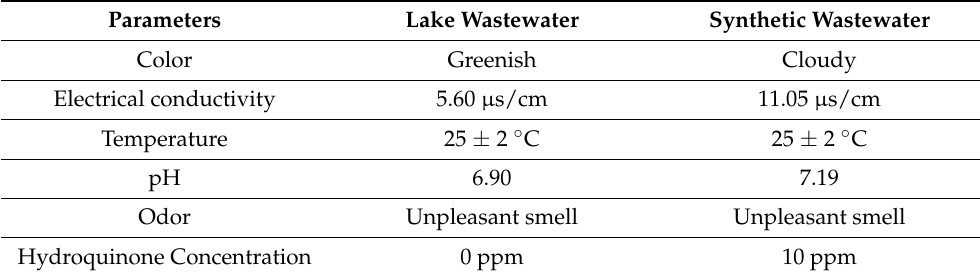
Table 1. The lake and synthetic wastewater parameters used.